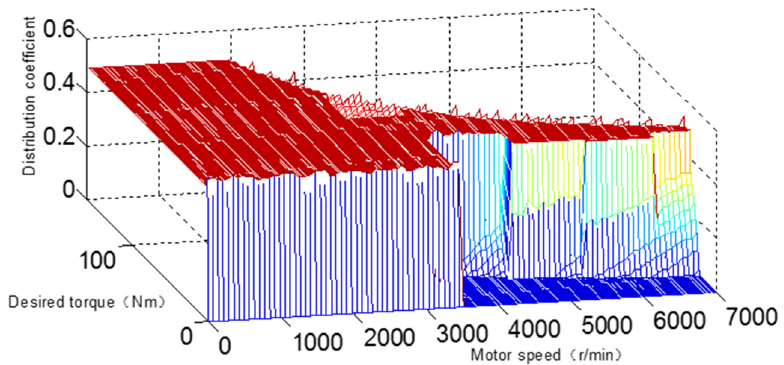
Figure 6 . The partition factor based on off-line